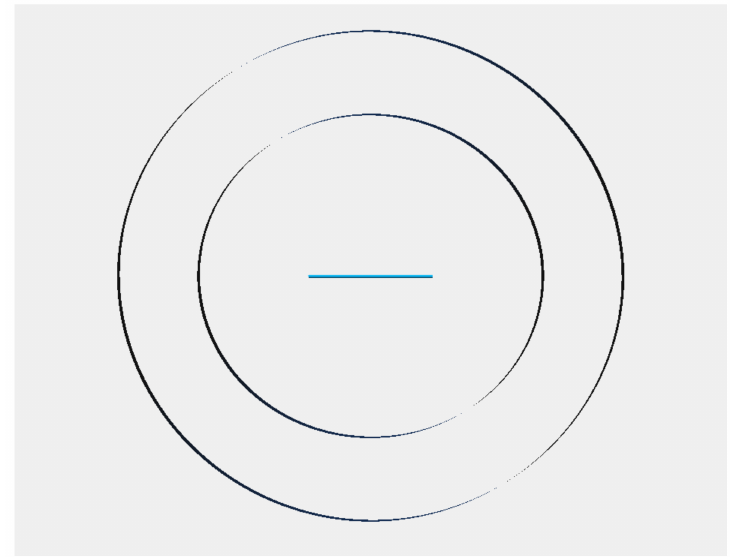
Figure 15. Pressure Iso-line in Conventional Analytical Model.